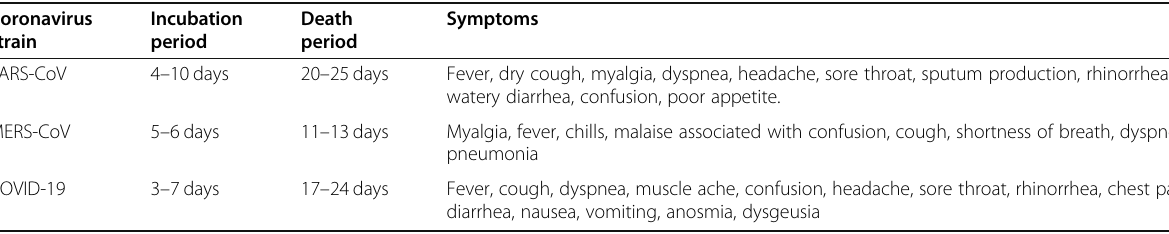
Table 4 Incubation period of coronaviruses Coronavirus